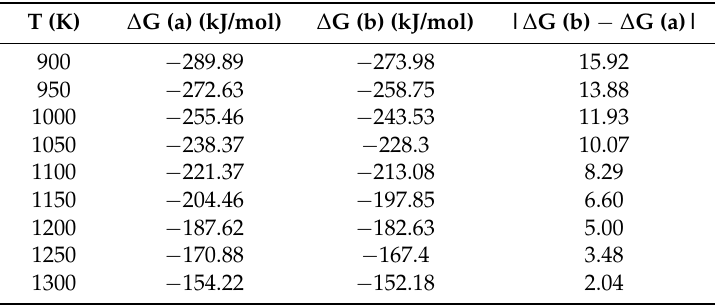
Comparison between ∆ G f values of (a) this study and (b) [25] for the reaction: